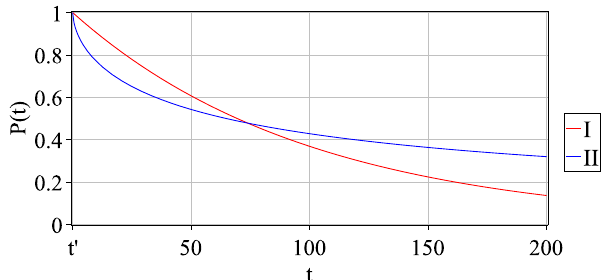
Figure 1. I—the plot of exponential distribution of probability P 11 ( t ) (2), II—the plot of probability distribution P 22 ( t )